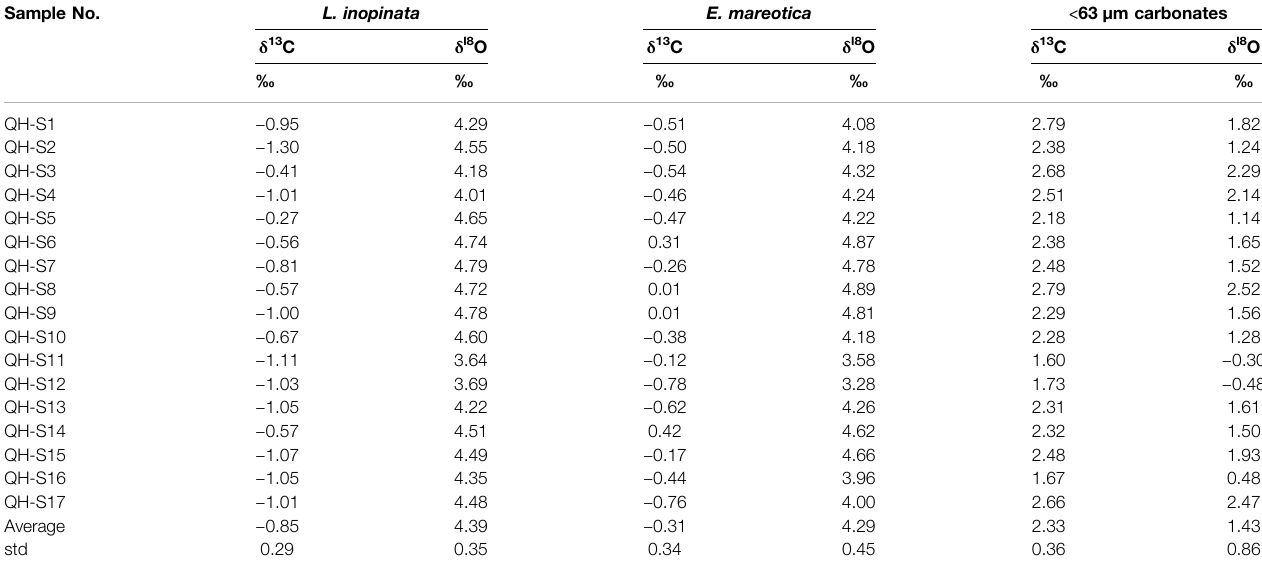
TABLE 2 | Oxygen and carbon isotopic compositions of ostracod shells ( L. inopinata and E. mareotica ) and carbonate fraction ( < 63 μ m) of surface sediments in Lake Qinghai. Sample